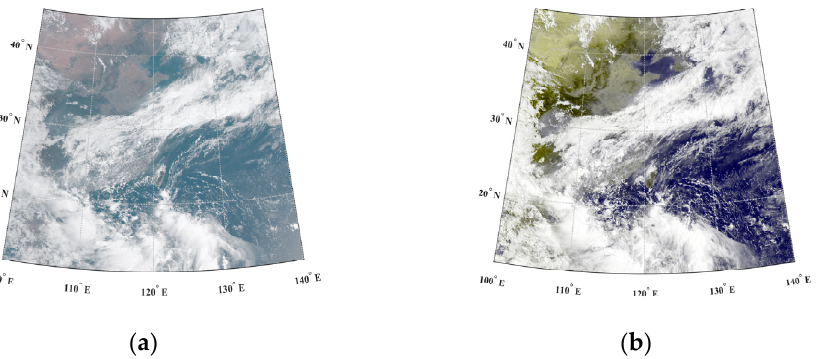
Figure 4. AHI true color composite imagery ( a ) before atmospheric correction and ( b ) after atmos- pheric correction.